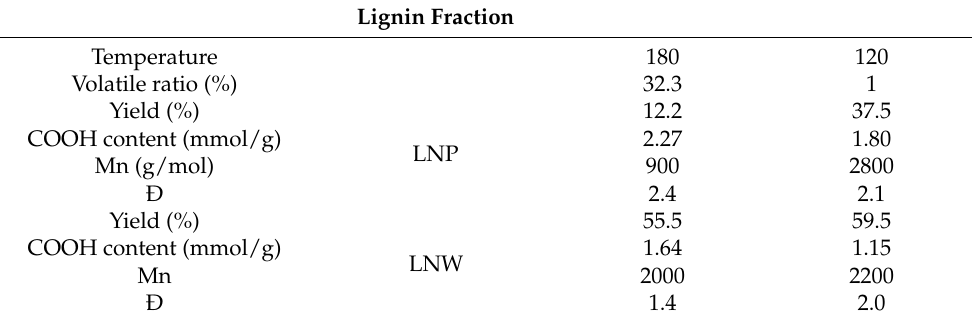
Table 3. Effect of temperature on the oxidative depolymerization of LN1 (10 Bar O 2 , 1 h); precipitated lignin (LNP), hydrosoluble lignin